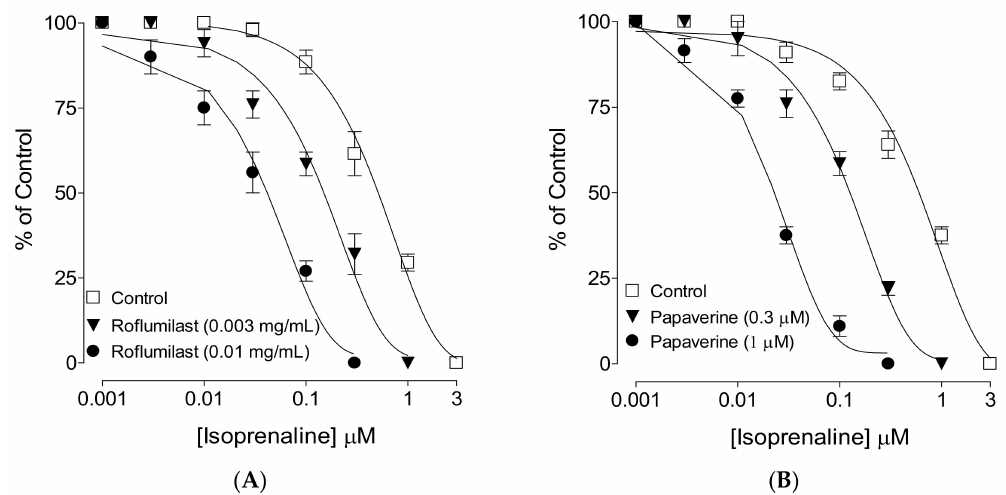
Figure 3. Inhibitory concentration–response curves of isoprenaline against carbachol (CCh)-induced contractionsintheabsenceandpresenceofdi ff erentconcentrationsof( A )roflumilastand( B )papaverine, in isolated rabbit jejunum preparations. Values shown are mean ± SEM, n = 4-5.